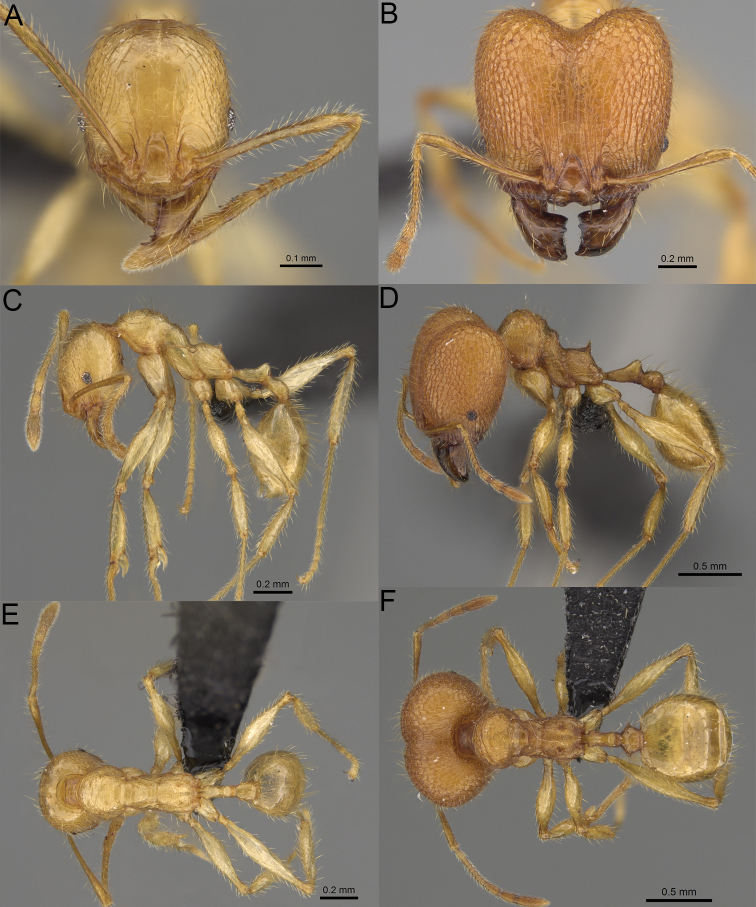
Pheidole
mavohavoana sp. nov., full-face view (A), profile (C), and dorsal view (E) of paratype minor worker (CASENT0059948) and full-face view (B), profile (D), and dorsal view (F) of holotype major worker (CASENT0923298).